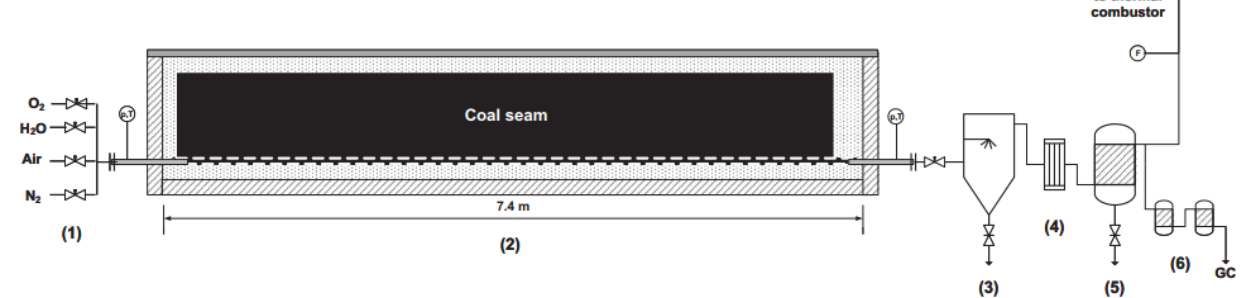
Figure 11. Schematic diagram of large-scale UCG experimental device (from [34]).